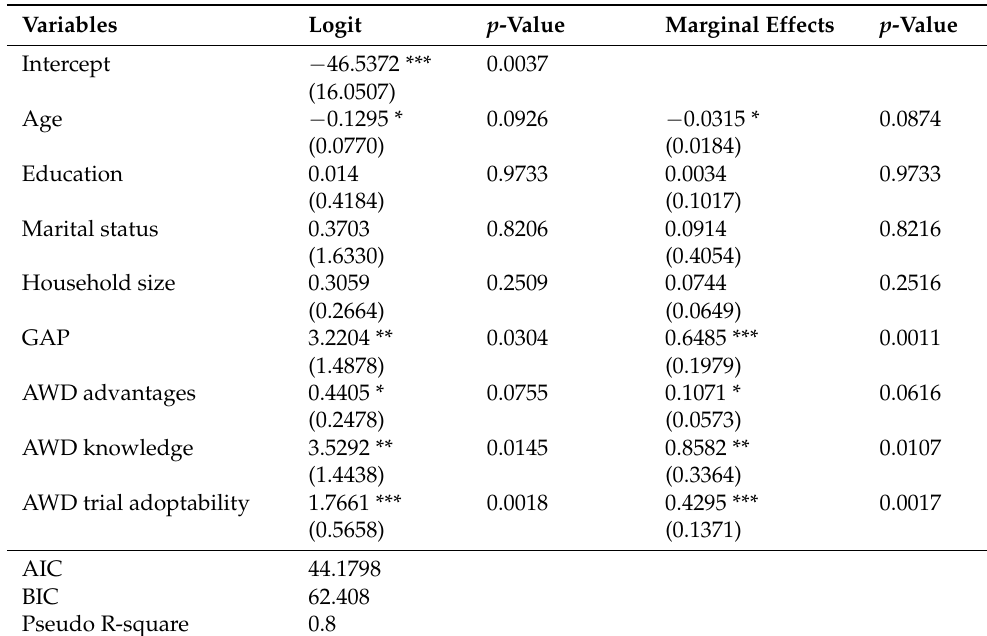
Table 4. Determinants of alternate wetting and drying